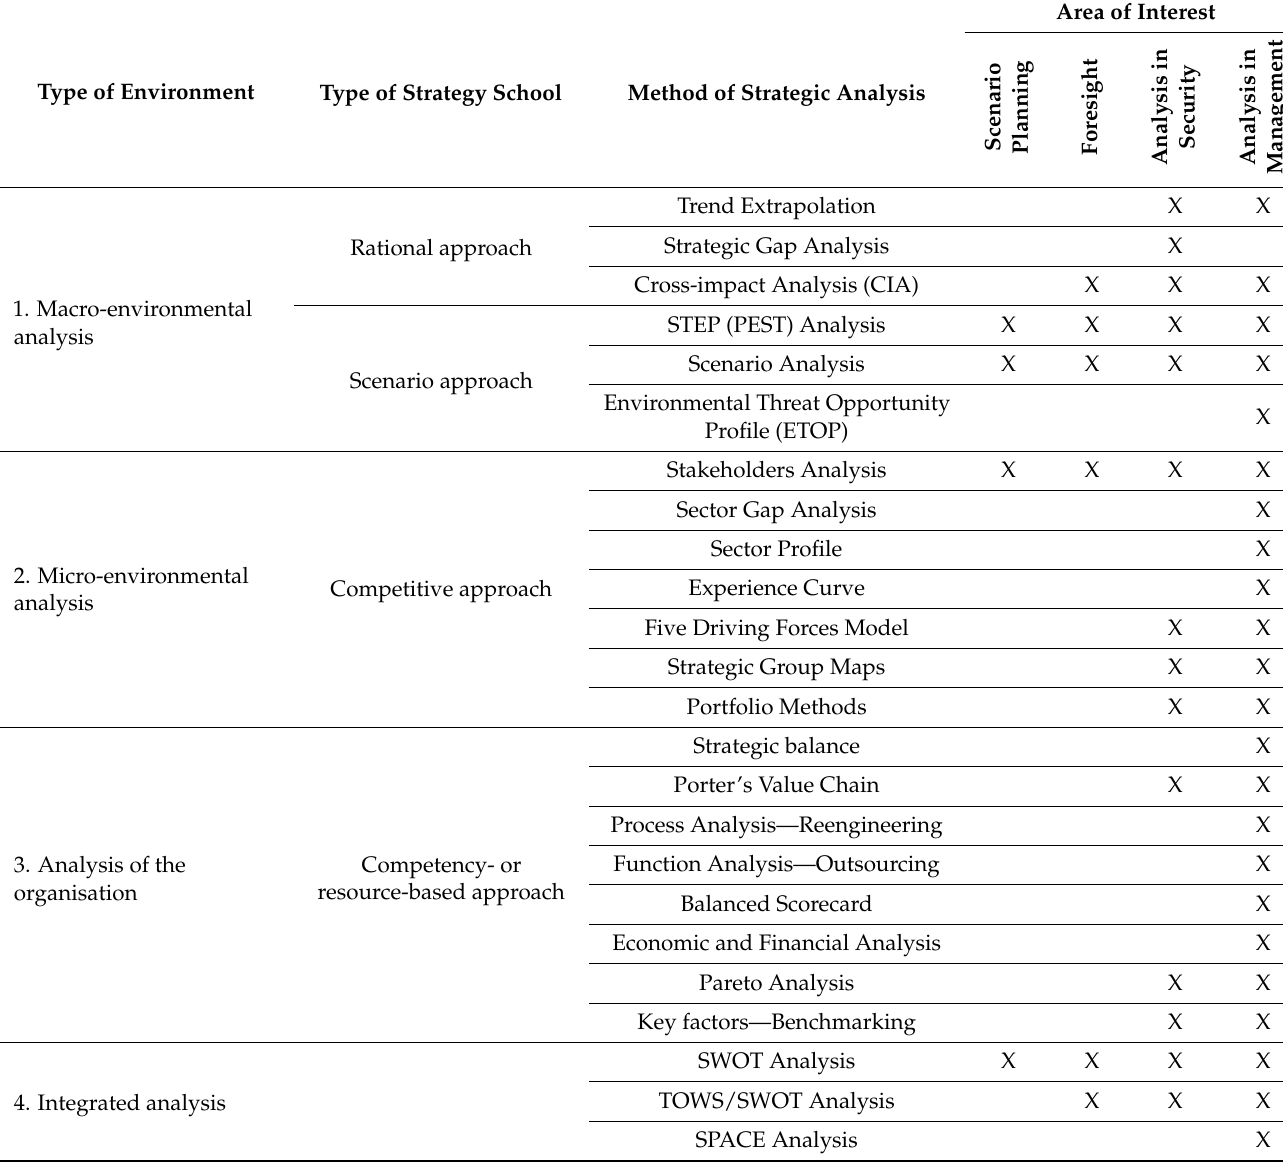
Table 4. Methods used in strategic analysis of energy security.